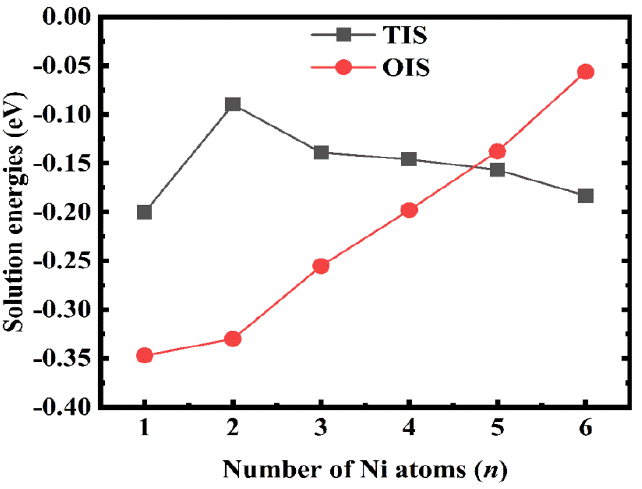
Figure 4. Solution energies of one H atom in TIS and OIS near ( n = 1–6) Ni atoms.